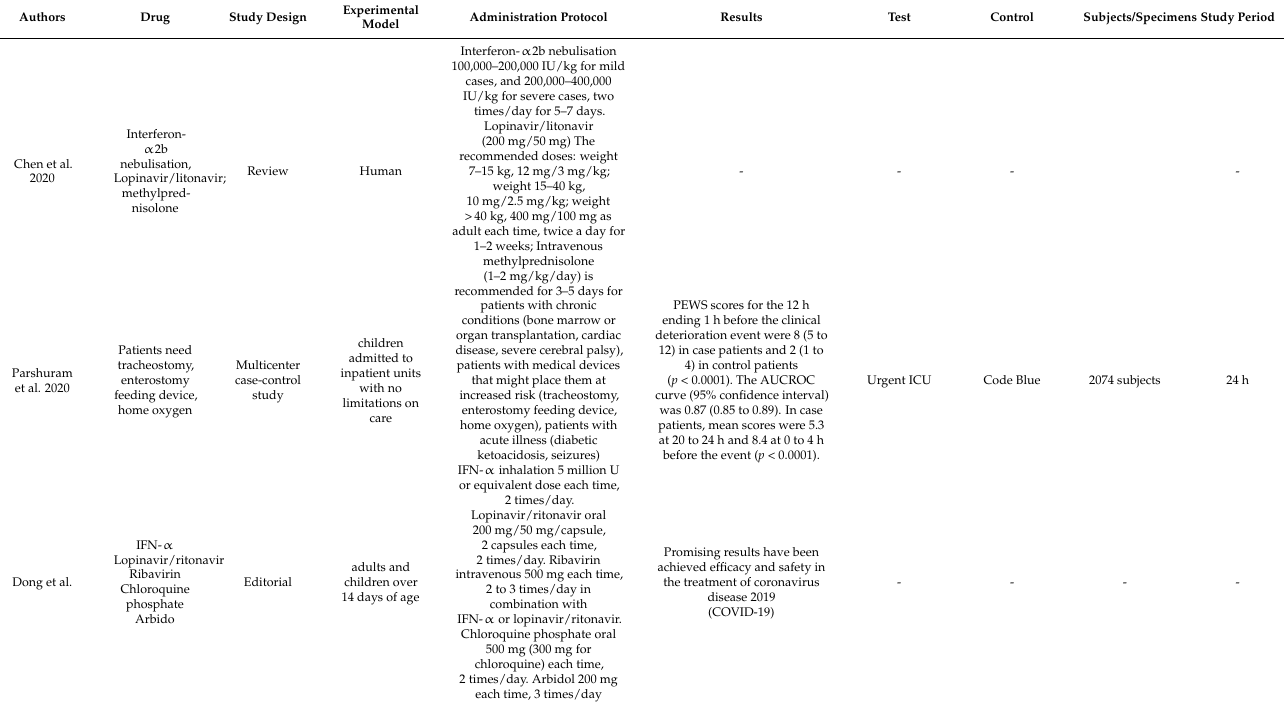
Table 4. Summary of COVID-19 adjuvant aerosol